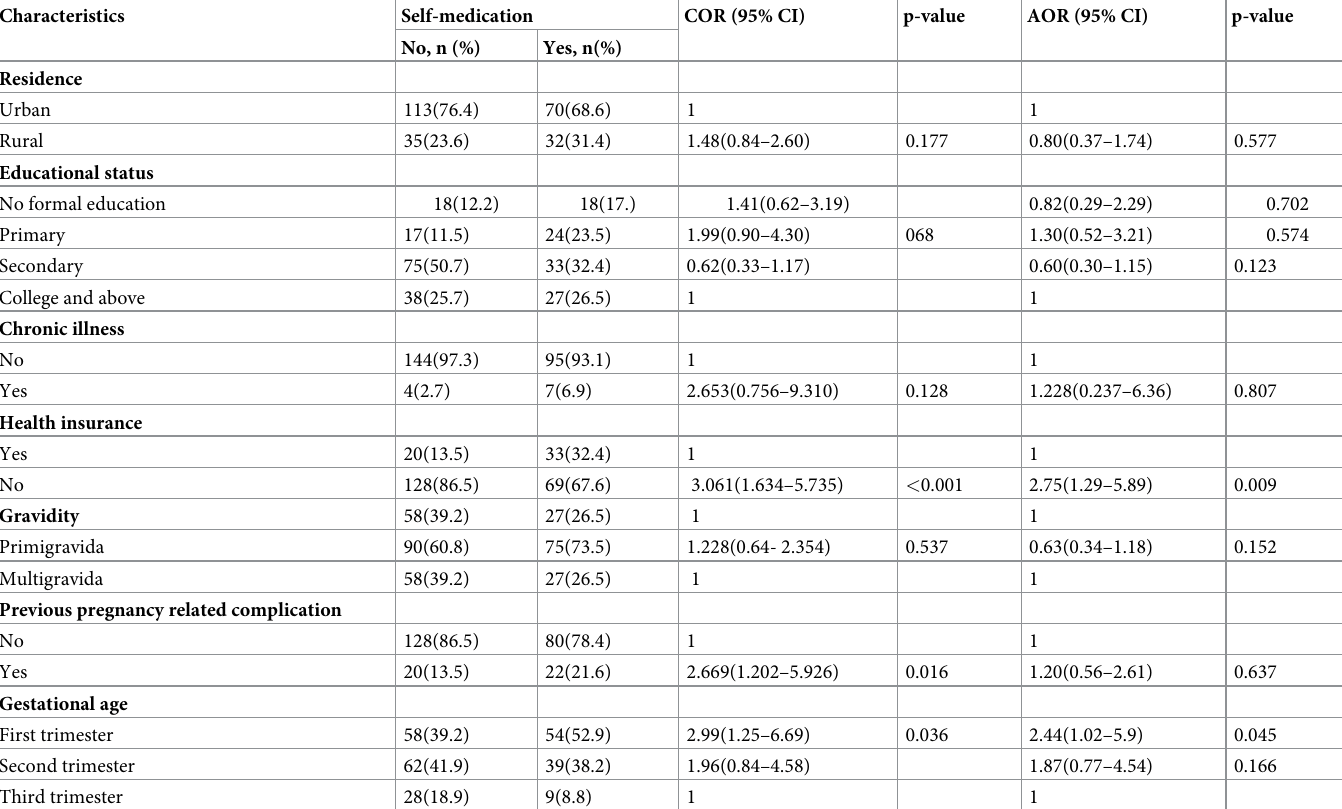
Table 4. Factors associated with self-medication practice during pregnancy (n = 250).